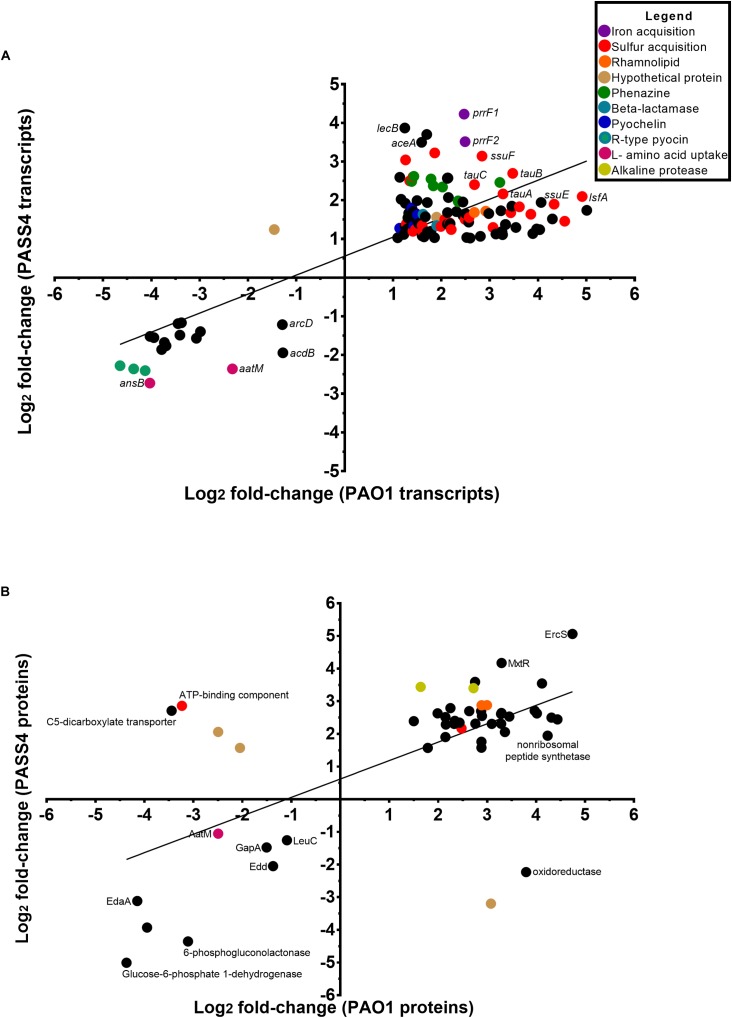
Comparison of the changes in expression at a transcript and protein level in P. aeruginosa PASS4 and PAO1 following growth in DNA; growth in asparagine was used as a reference. (A) The chart shows log2 fold changes of transcript data from RNA-sequencing (P < 0.01, log2 fold-change 1< to <–1). Correlation of PASS4 and PAO1 transcript data was moderately similar (R2 = 0.5983). (B) The chart shows log2 fold changes of shotgun protein data (P < 0.05, log2 fold-change 1< to <–1). Correlation of PASS4 and PAO1 protein data was moderately similar (R2 = 0.4072).